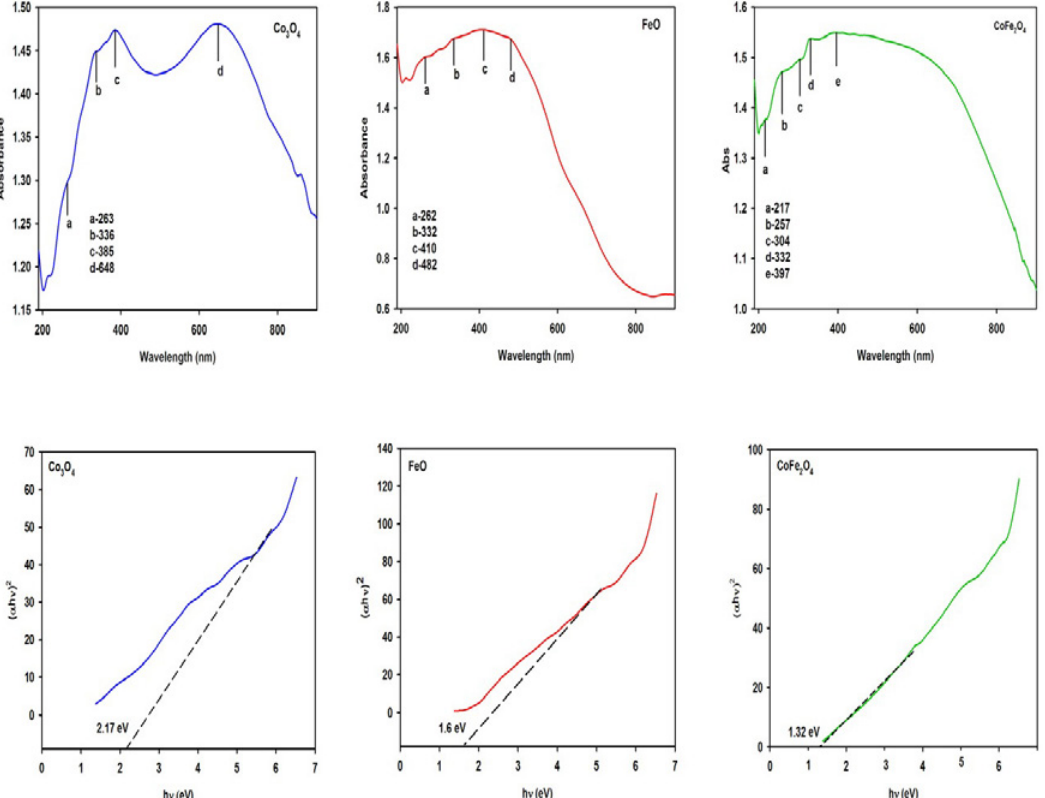
Fig. 6.UV-Vis diffuse reflectance spectra and tauk plots of cobalt oxide, iron oxide and cobalt ferrite nanoparticles prepared by wet chemical route after